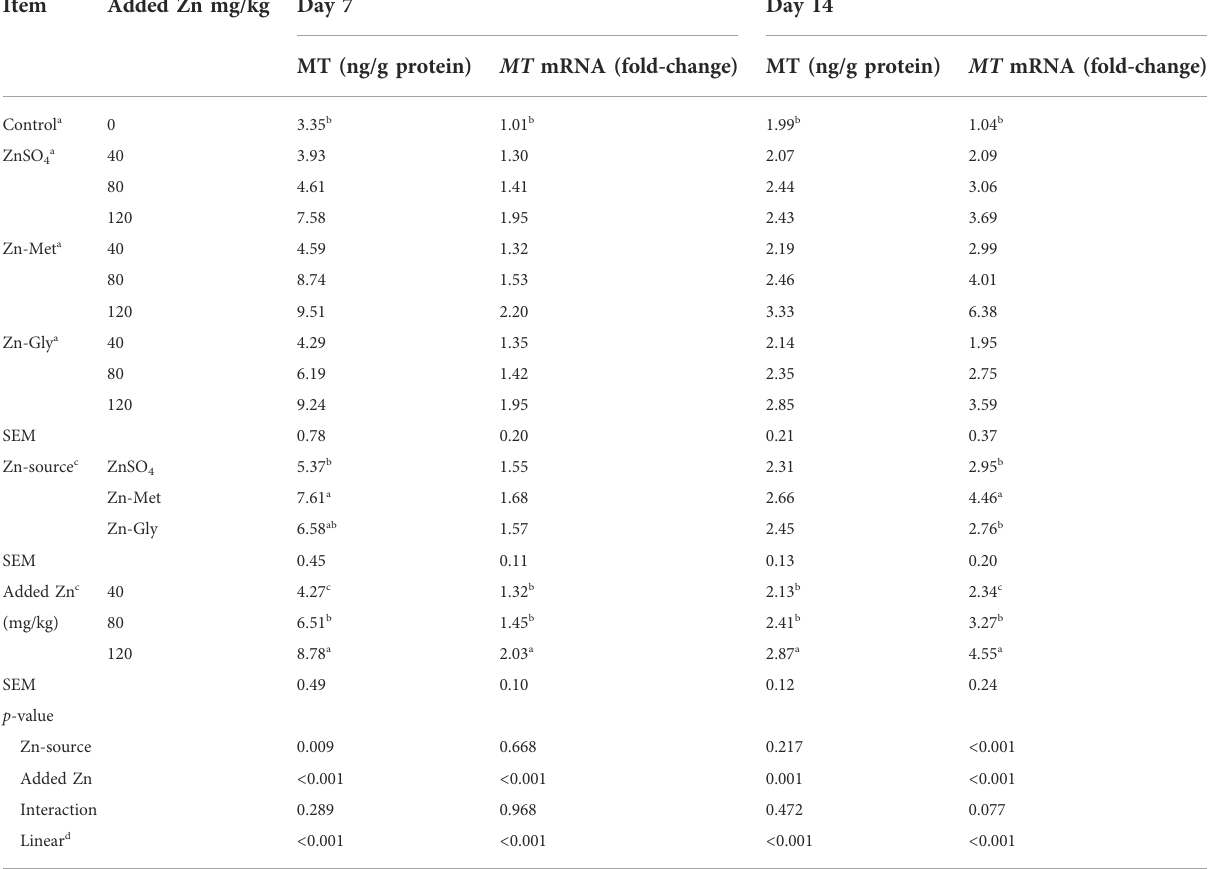
TABLE 5 Effects of supplemental Zn source and zinc level on the concentration and mRNA abundance of metallothionine in the pancreas of broilers.